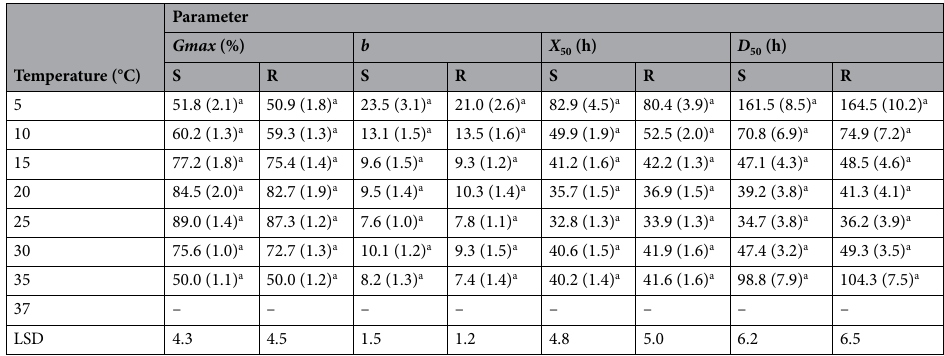
Table 2. Parameter estimates resulted from the fitting of three-parameter sigmoidal function to seed germination data associated with herbicide-resistant (R) and -susceptible (S) winter wild oat biotypes over time under different temperatures. The values in parentheses denote standard error. Similar letters denote insignificant difference between the R and S biotype in each parameter. Gmax : maximum germination percentage; b : slope at X 50 ; X 50 : time to 50% of maximum germination at each temperature; D 50 : time to 50% germination.